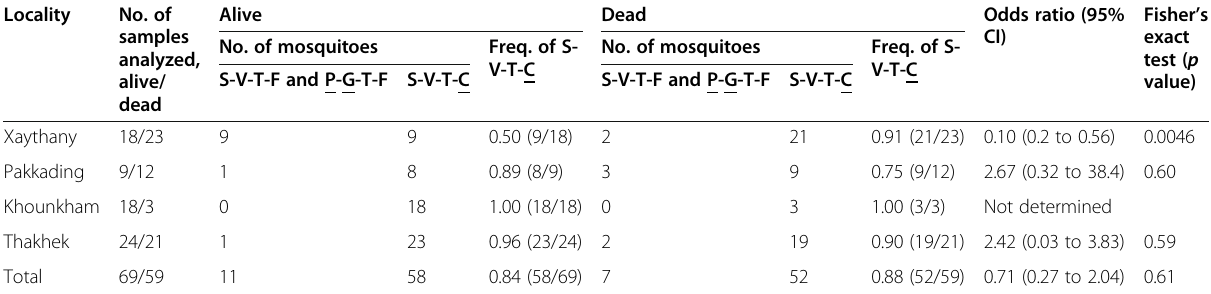
Table 3 Associations between the S-V-T-C haplotype and deltamethrin resistance among Ae. aegypti larvae collected from four populations Locality